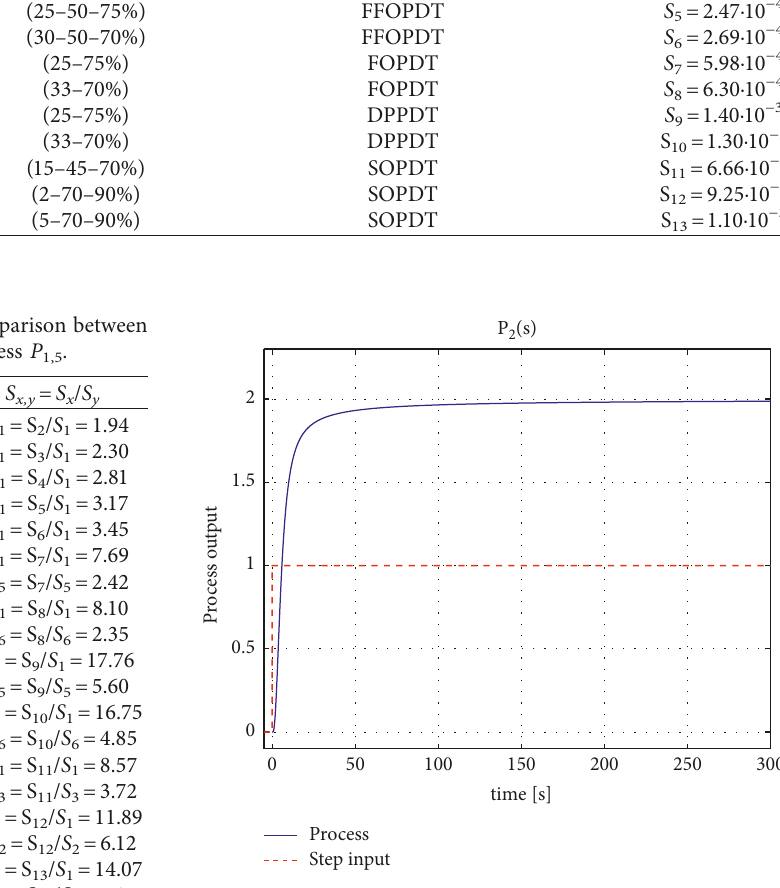
Figure 15: Step-input signal and process reaction curve for process P 2